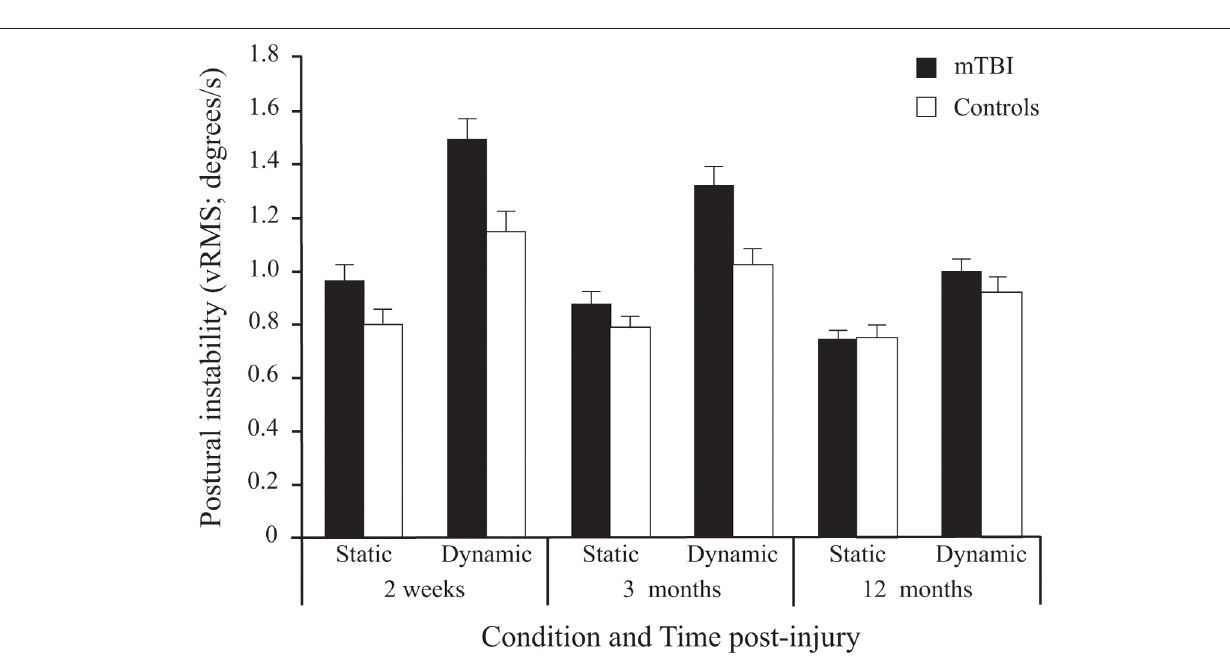
FIGURE 4 | Between-Group differences (Mean ± SEM mTBI vs. Mean ± SEM Controls) in Postural Instability (vRMS; degrees/s) as a function of Condition and Time post-injury (Session). Note that since stimulus Frequency did not significantly influence inter-group differences, only average values of the three frequencies are shown